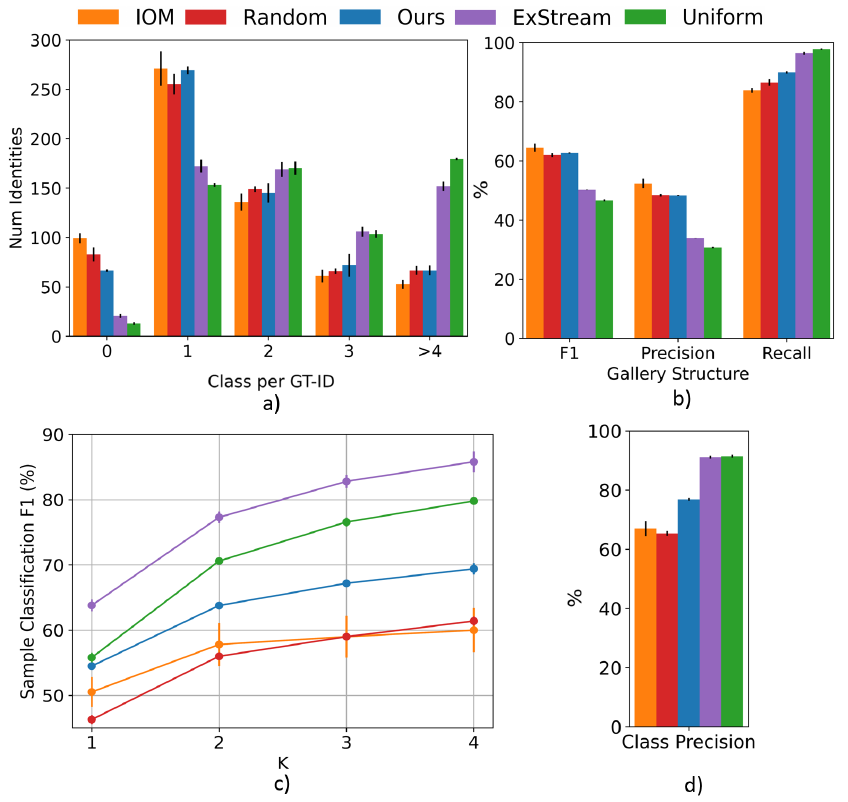
Figure 6. Data selection method comparison with the MARS dataset. We analyze ( a ) the number of classes created ( x -axis) per GT-ID in the dataset ( y -axis) showing the number of GT-ID with more than one class associated or those GT-ID that have not been correctly found, i.e., 0 classes associated; ( b ) gallery structure metrics: F 1, precision, and recall; ( c ) sample classification F 1 analyzing the influence of varying K ; ( d ) class precision. Table 1. Detailed results of the proposed framework on the MARS and DukeMTMC-VideoReID datasets. The results show the mean and the standard deviation of the three iterations performed, mean ( ±